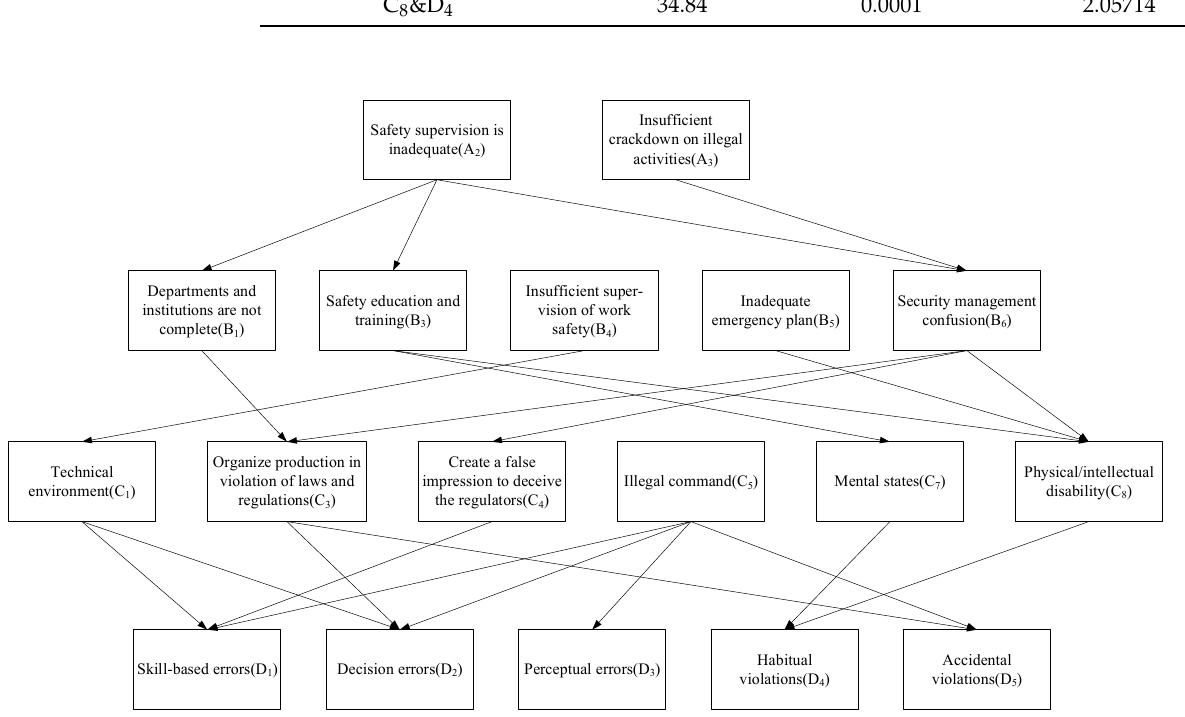
Figure 4. Initial BN model for unsafe acts in gas explosion accidents.